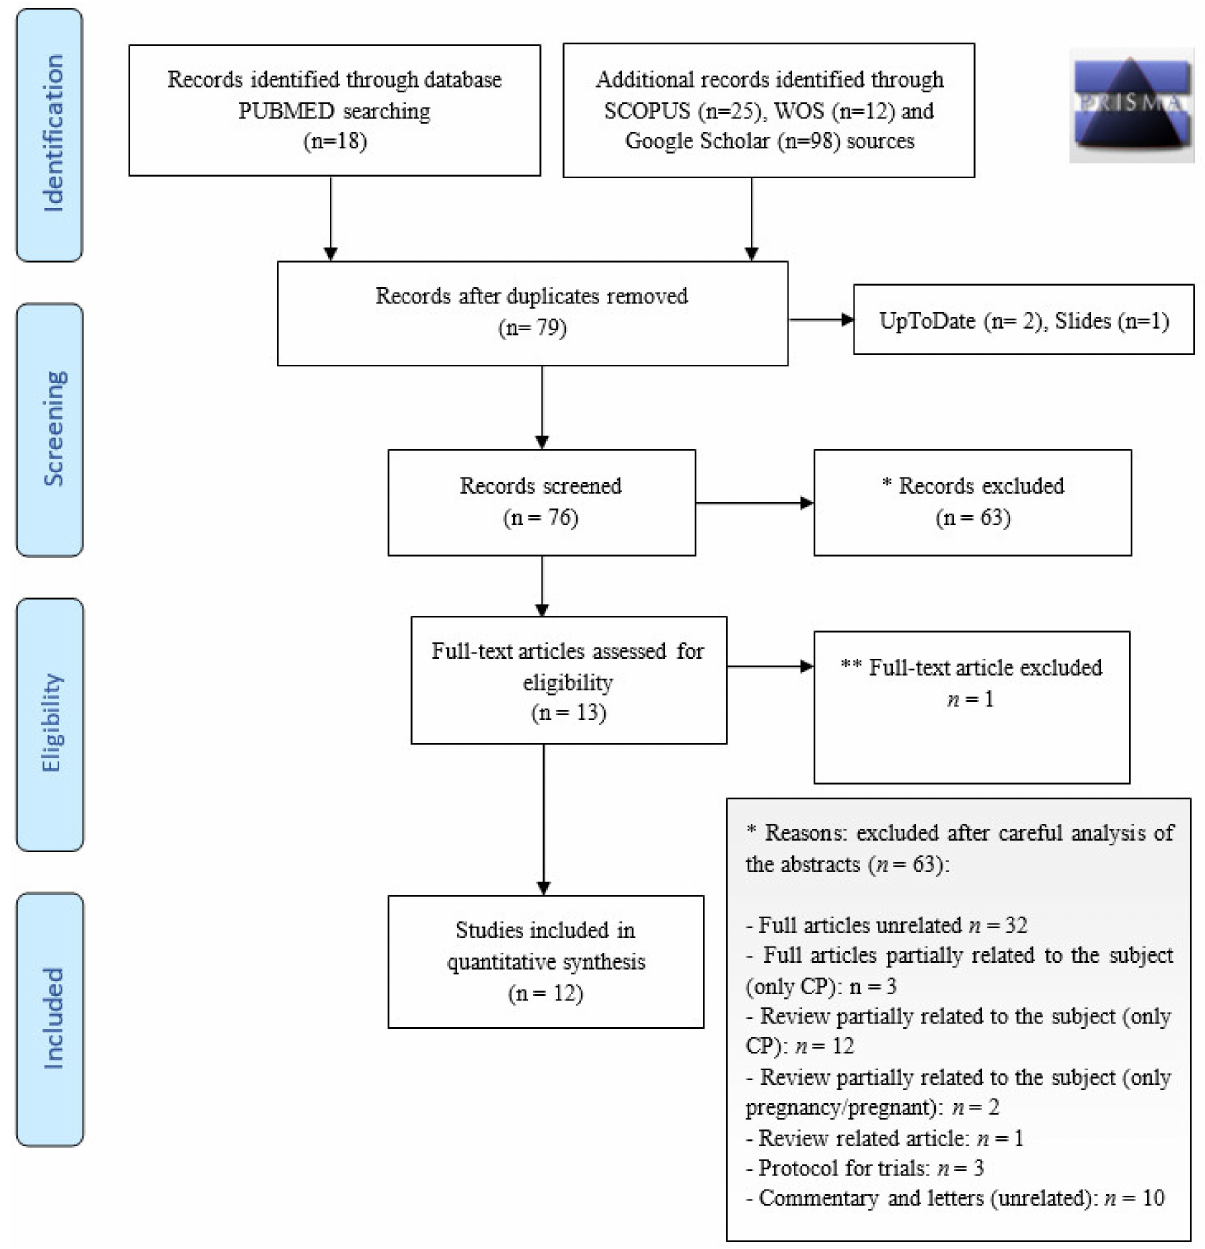
Figure 1. PRISMA 2009 Flow Diagram. * Records were excluded because: although full articles, they were unrelated to the subject; they were only partially related to the subject (i.e., they mentioned only pregnancy or only convalescent plasma treatment); they were not full articles, (i.e., they were reviews, review-related articles, trial protocols, commentaries or letters. ** One article was removed after careful analysis of the full